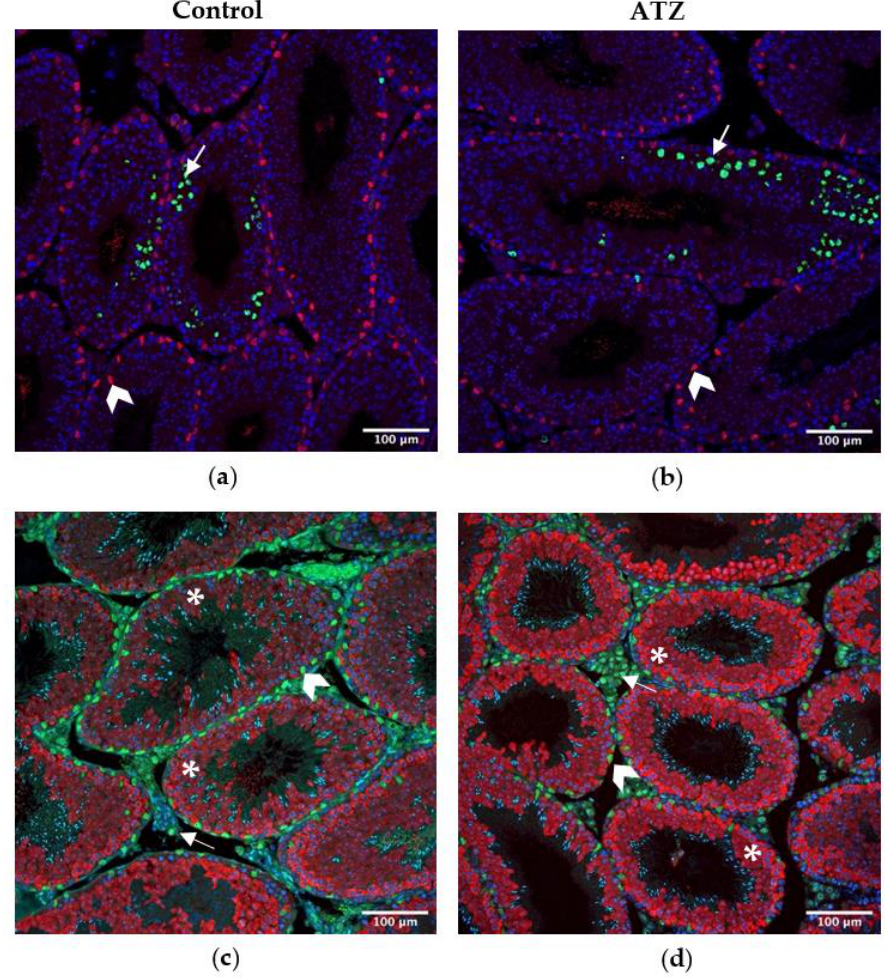
Figure 4. Representative immunofluorescence of testis sections at 200X of the F1 control ( a , c ) and ATZ exposed ( b , d ) 6-month cohort. ( a , b ) immunolabelling of SOX9 (Sertoli cells, red) and of proliferating cells with an antibody raised to phospho-histone H3 (P-HH3, green), with a DAPI counterstain (showing the nuclei, blue). White arrows indicate proliferating cells and white arrow heads indicate Sertoli cells ( c , d ) immunolabelling of GATA4 (Sertoli and Leydig cell, green) and of DDX4 (germ cells, red), with a DAPI counterstain (showing the nuclei, blue). White arrows indicate Leydig cells, white arrowhead indicates Sertoli cells and white asterisks indicate germ cells. Scale bar = 100 µm. ATZ = atrazine.